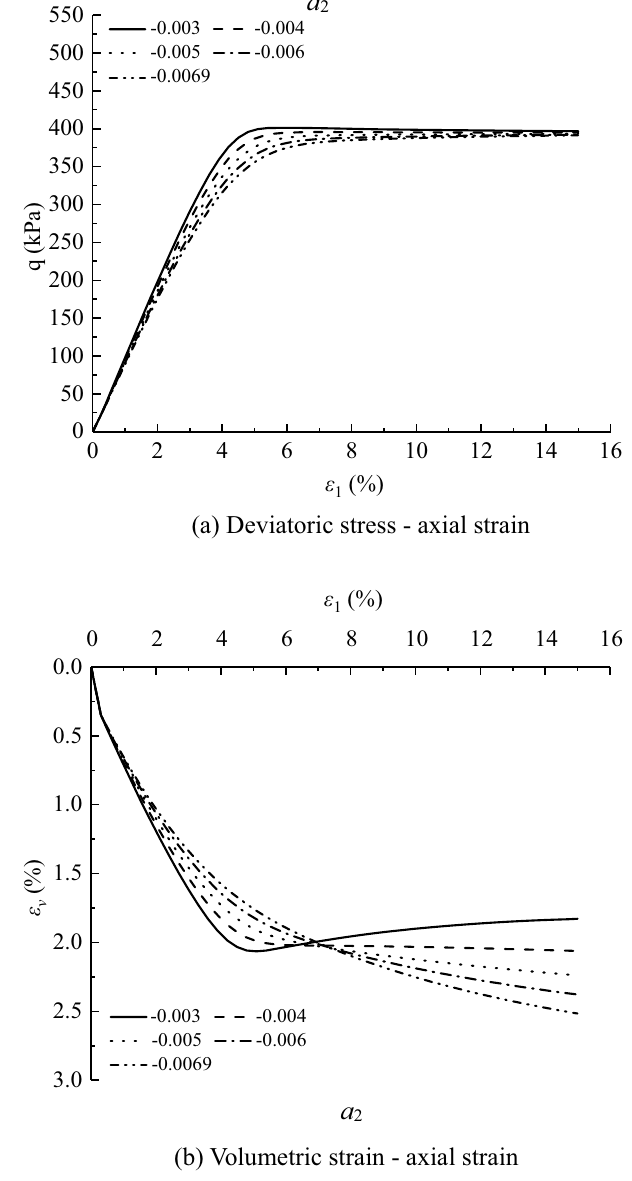
Figure 13. Sensitivity analysis of simulation results with varying a 2